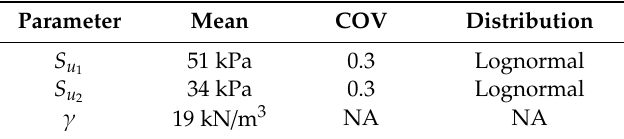
Figure 1. Slope geometry and deterministic slope stability analysis results for example I. Table 2. Statistics of soil properties in example I.